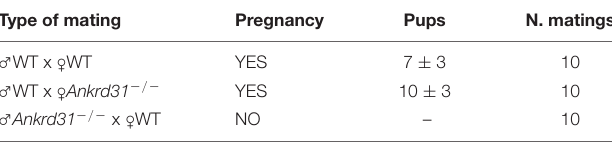
TABLE 2 | Fertility test in Ankrd31 − / − female and male mice. Type of mating Pregnancy